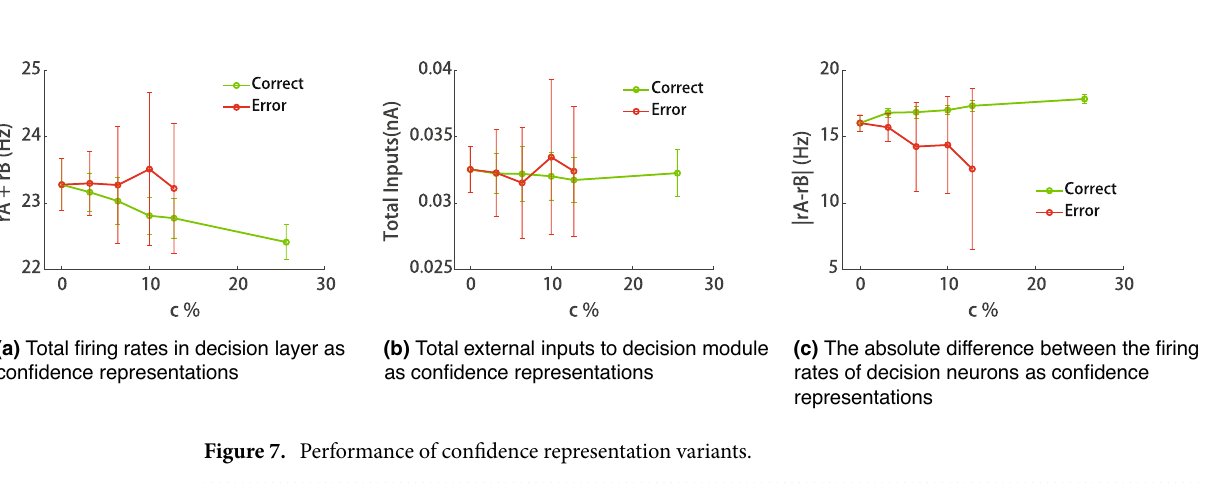
Figure 7. Performance of confidence representation